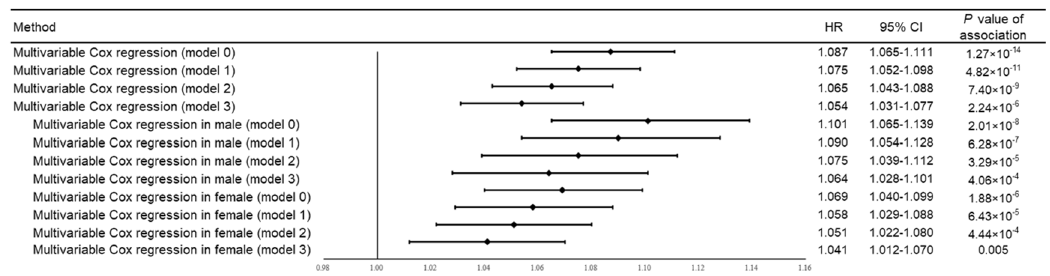
Fig. 3 Forest plot of observational analyses for the relationships of sleep risk score with fracture risk. The 95% con fi dence interval was presented in the error bar. Model 0 was adjusted for confounders, including age, education, sex, smoking, alcohol consumption, physical activity, body mass index, and the use of glucocorticoid, benzodiazepines, and antidepressants; Model 1 = Model 0 + BMD; Model 2 = Model 0 + falls; Model 3 = Model 0 + BMD + falls. BMD bone mineral density, CI con fi dence interval, IVW inverse-variance weighted, MR Mendelian randomization, MR-PRESSO MR pleiotropy residual sum and outlier, OR odds